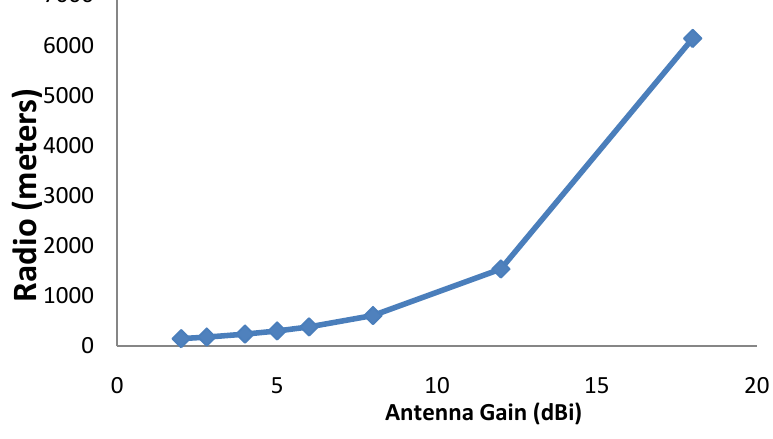
Figure 2. Radio coverage for several typical antenna